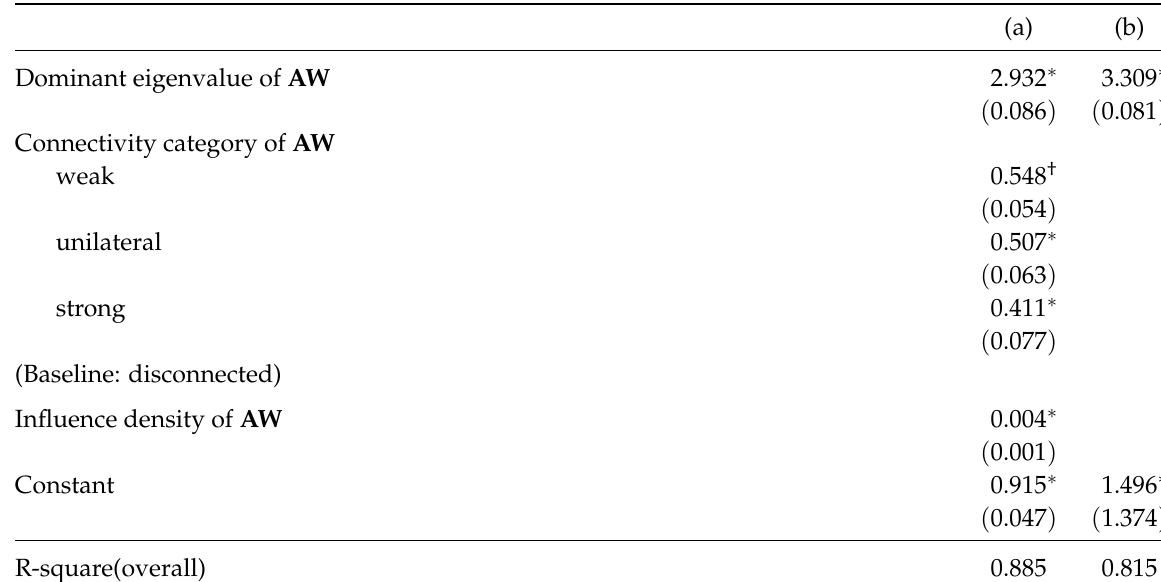
Table 5: ln ( stab ) predictors. Standard errors are in parentheses.